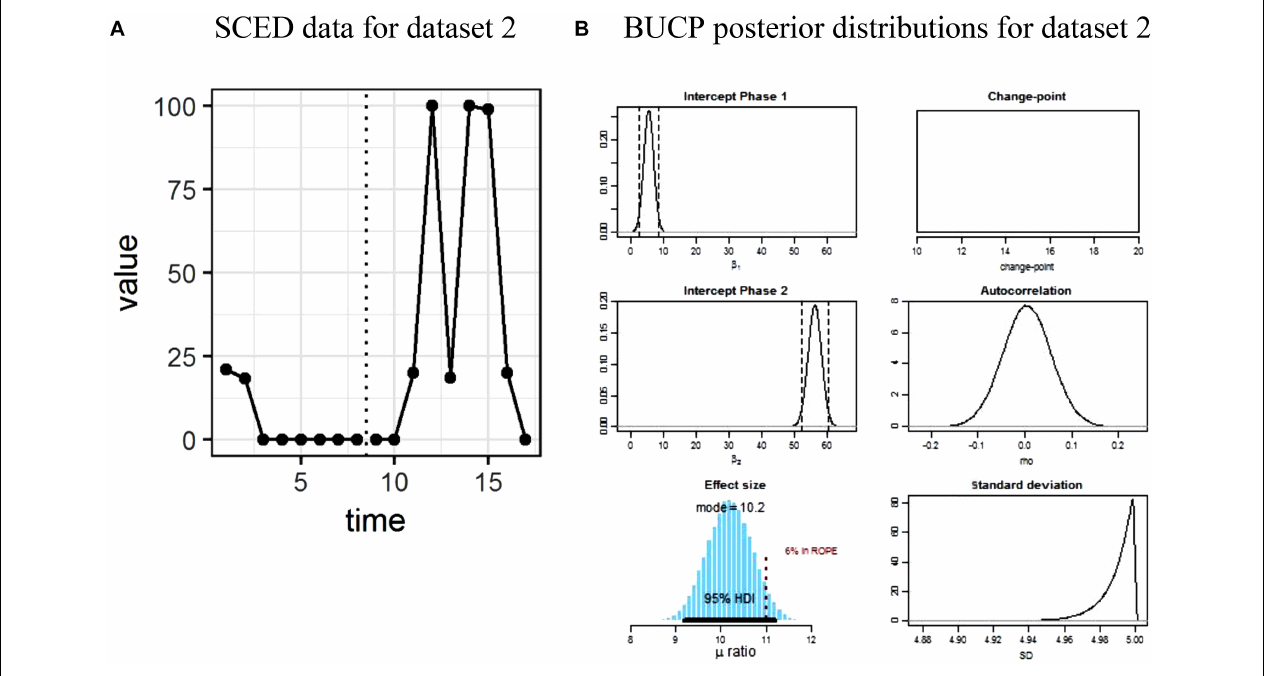
FIGURE 3 | (A,B) Single case experimental design (SCED) raw data for dataset 2 paired with the posterior distributions obtained with Bayesian unknown change-point (BUCP).